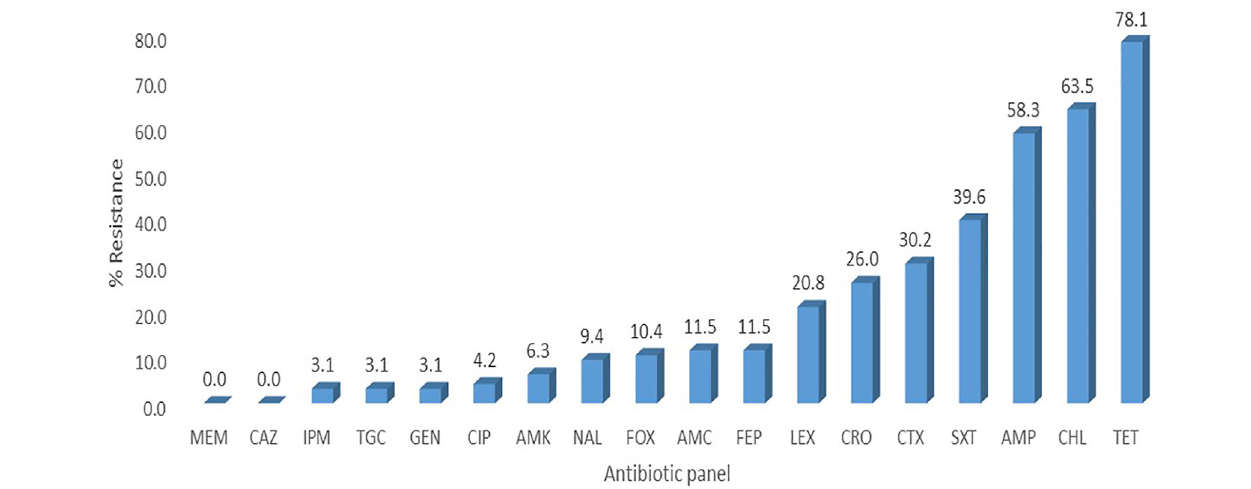
( Figure 2 ). The overall prevalence of antibiotic-resistant E. coli in the litter-amended soil was statistically signi fi cantly higher than in the soil samples before amendment ( p (cid:1) 0.001) and chicken litter ( p (cid:1) 0.001) ( Supplementary Table S2 ).